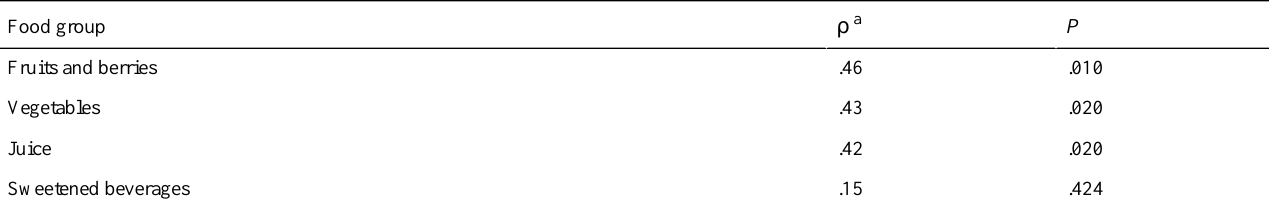
Table 2. Correlation coefficients between food intakes (grams/day) estimated using TECH and KidMeal-Q (N=30).